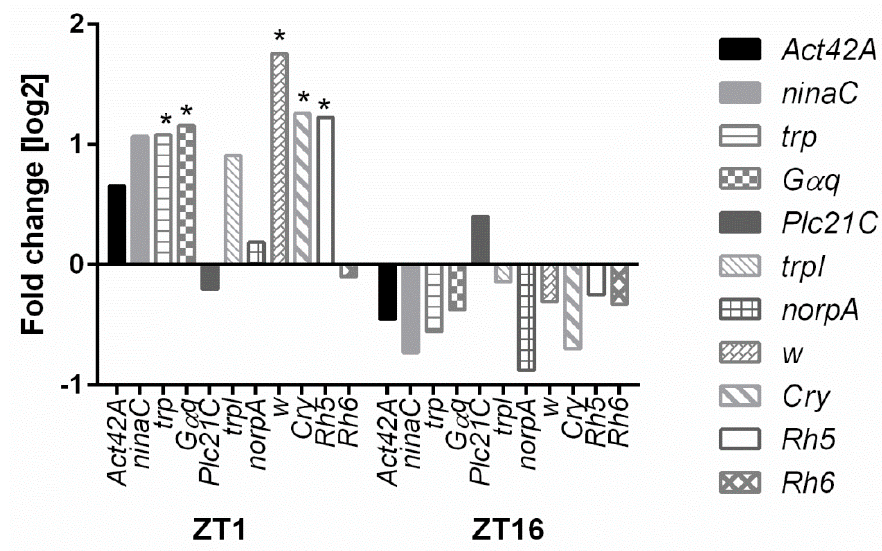
Figure 1. Microarray data of the phototransduction pathway genes. Differences in the selected gene expression levels are shown between GMR> hoRNAi and GMR> Valium10 (control) at ZT1 and ZT16. The following genes were examined: Act42A, ninaC, trp, G α q, PLC21C, trpl, norpA, w , Crystalline ( Cry ), Rh5 , and Rh6 . Statistically significant differences are marked with asterisks, * p ≤ 0.05.